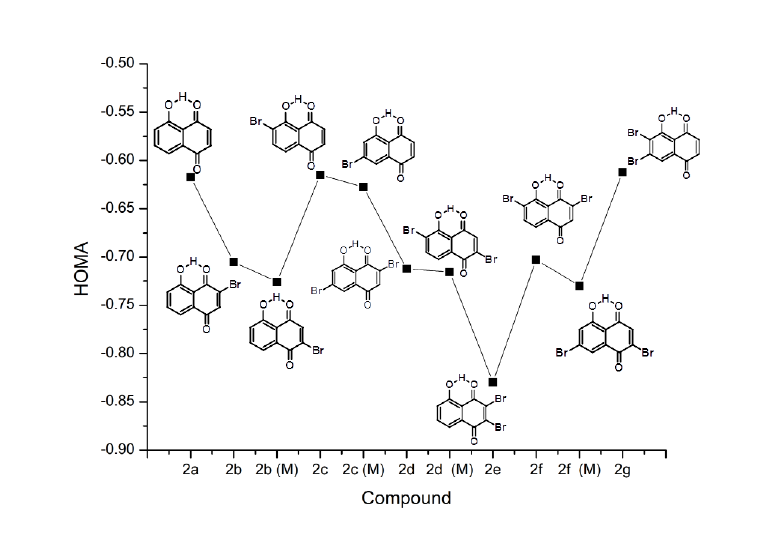
Figure 3. The HOMA aromaticity index evolution of the quinoid ring as a result of substitution by –Br and hydroxyl group in the compounds of group 2 .